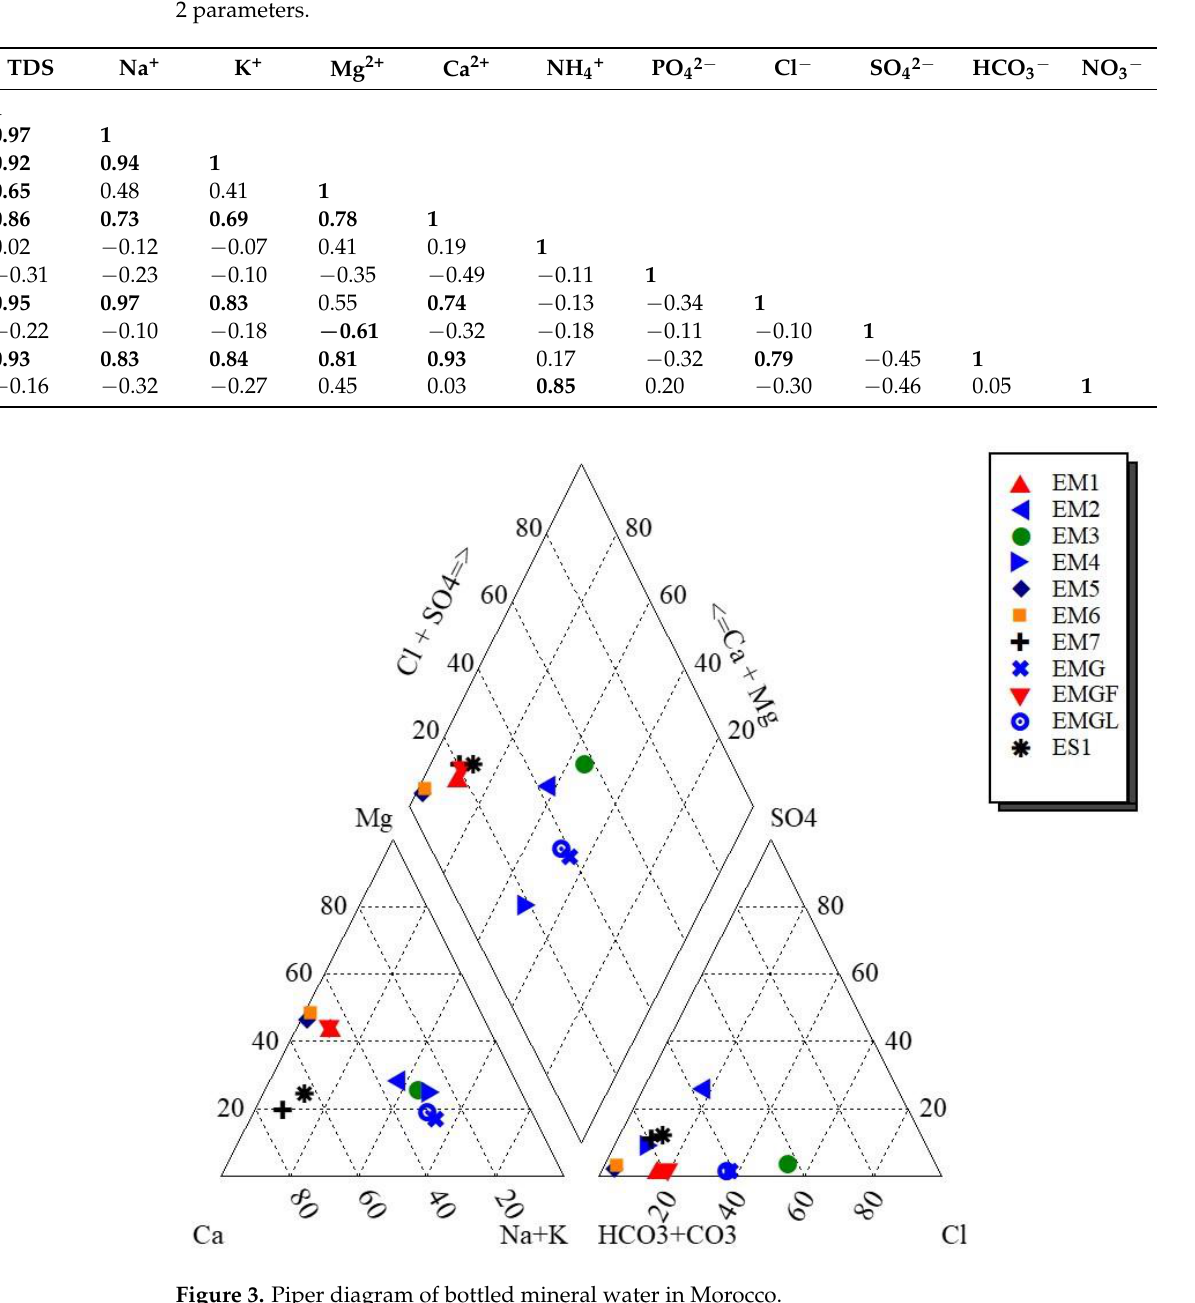
Figure 3. Piper diagram of bottled mineral water in Morocco.